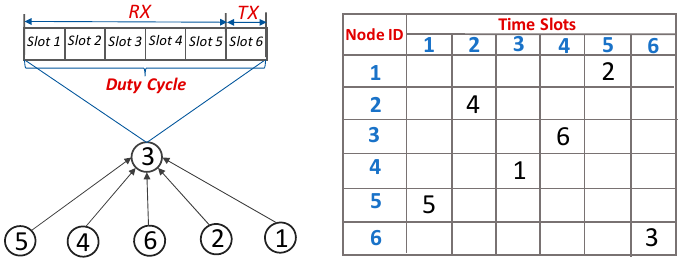
Figure 3. Power consumption of parent node in duty cycle.